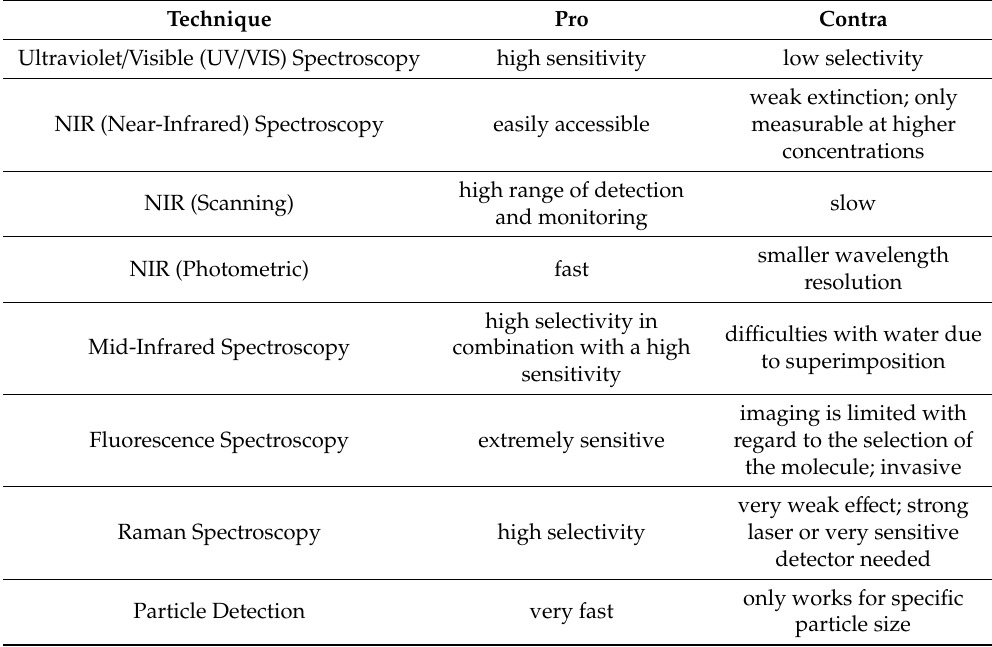
Table 1. Summary of the di ff erent measurement